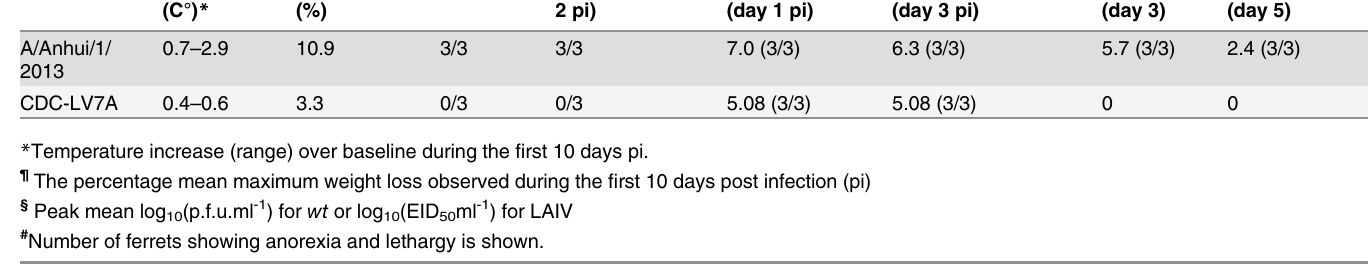
Table 5. Clinical signs and virus replication of A(H7N9) wt and LAIV viruses in ferrets. Clinical signs